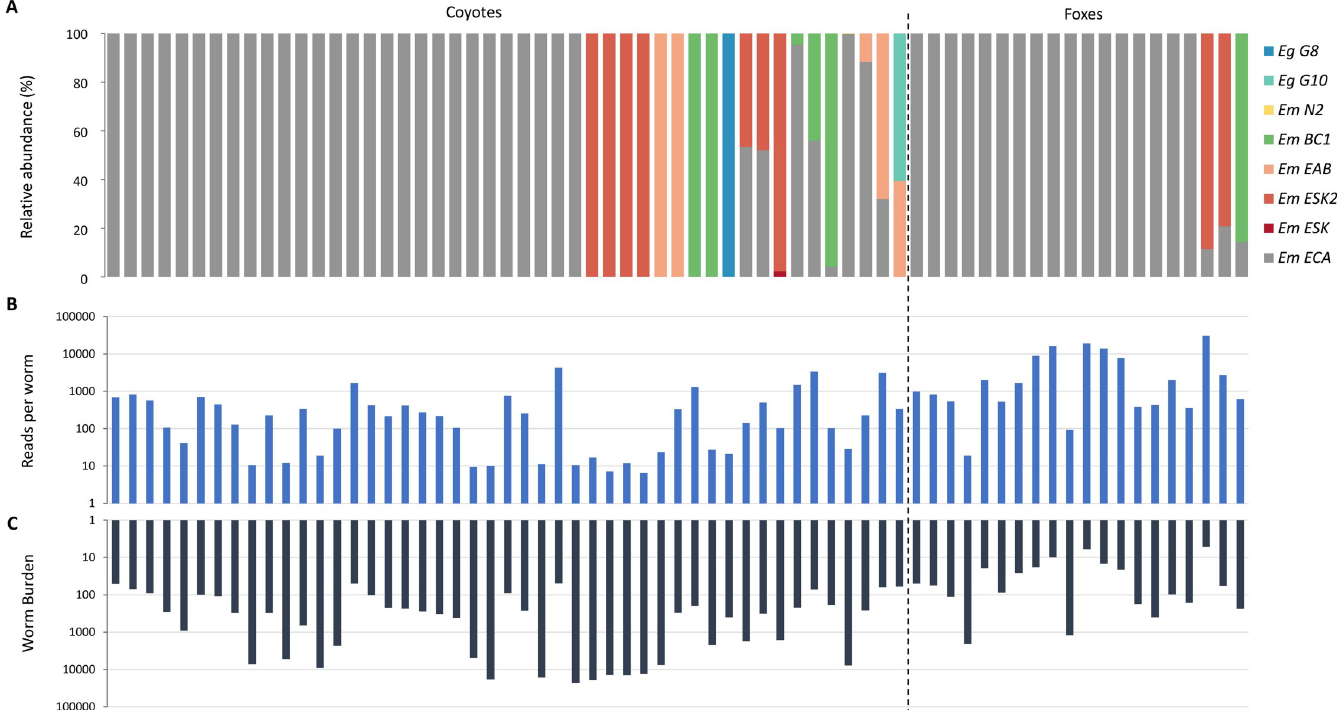
Fig 2. Deep amplicon sequencing assay results. Panel A. Relative abundance (%) of E . multilocularis and E . granulosus s . l . haplotypes per host. The percentage of reads corresponding to different ASVs (amplicon sequence variant) at each locus ( cob , cox1_A , cox1_B , nad1 ) was concatenated to identify the final haplotype and their final relative proportion in each sample. We identified in total eight haplotypes: E . multilocularis (Em) ECA, ESK, ESK2, EAB, BC1, N2, and the E . granulosus s . l . (Eg) G8 and G10. The ESK2 was the only new Em haplotype. Panel B and C . Comparison of the total reads per worm ( A ) and the number of worms per sample ( B ). According to the number of worms processed per host, we obtain a read depth of approximately 7 to more than 30,000 reads per worm. The average read depth per sample was 117,479 (range 8,351–325,480).